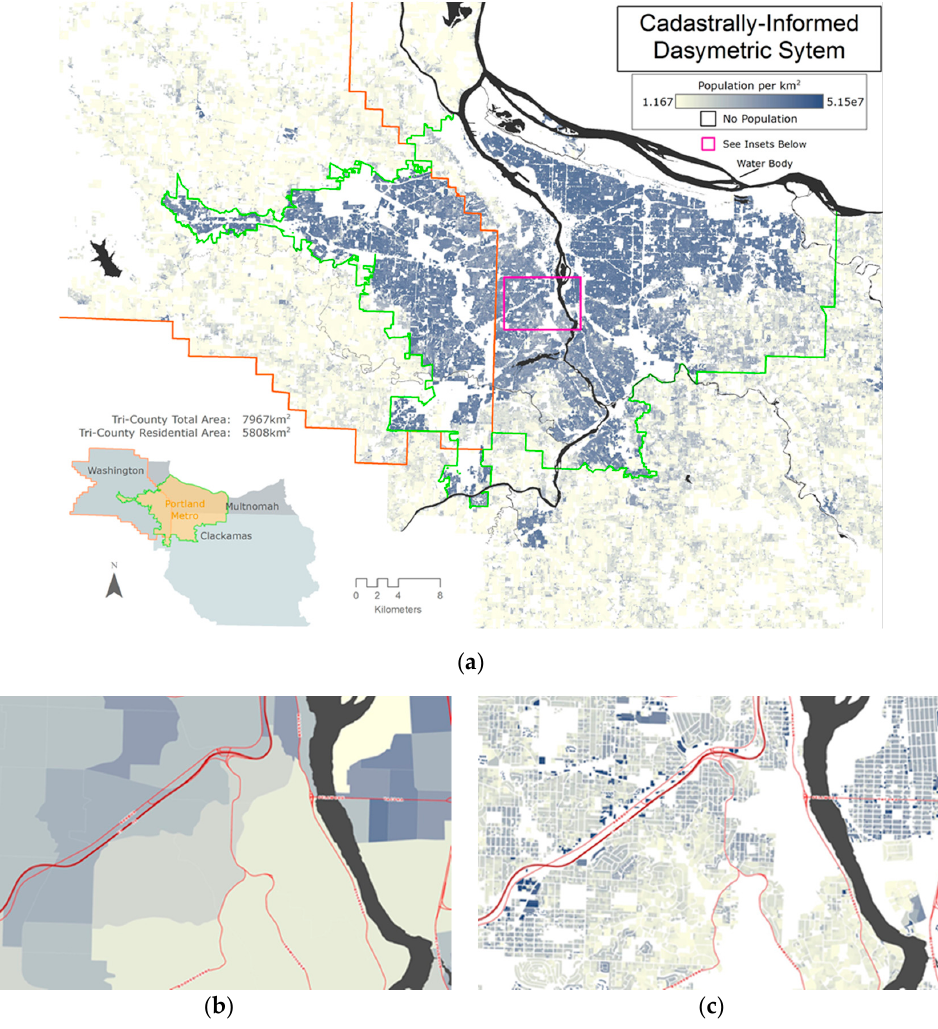
Figure 1. ( a ) ( Above ) the cadastrally-informed dasymetric map of the Portland Metropolitan region; ( b ) ( Left ) choropleth map of population density (population of Census Block Group divided by area of Census Block Group); and ( c ) ( Right ) dasymetric map of population density.